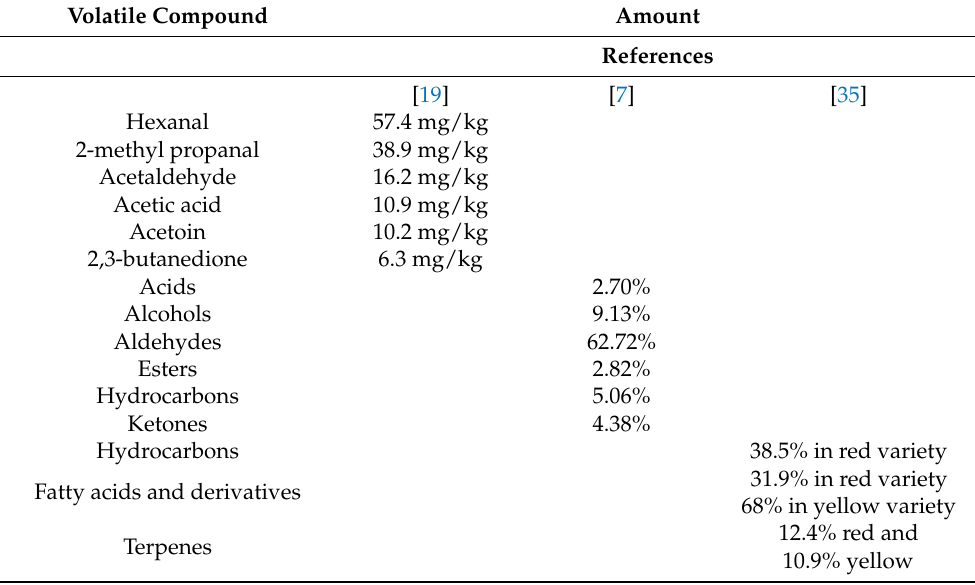
Table 5. The main classes of volatile compounds of cactus seed oil reported in the literature. Volatile Compound